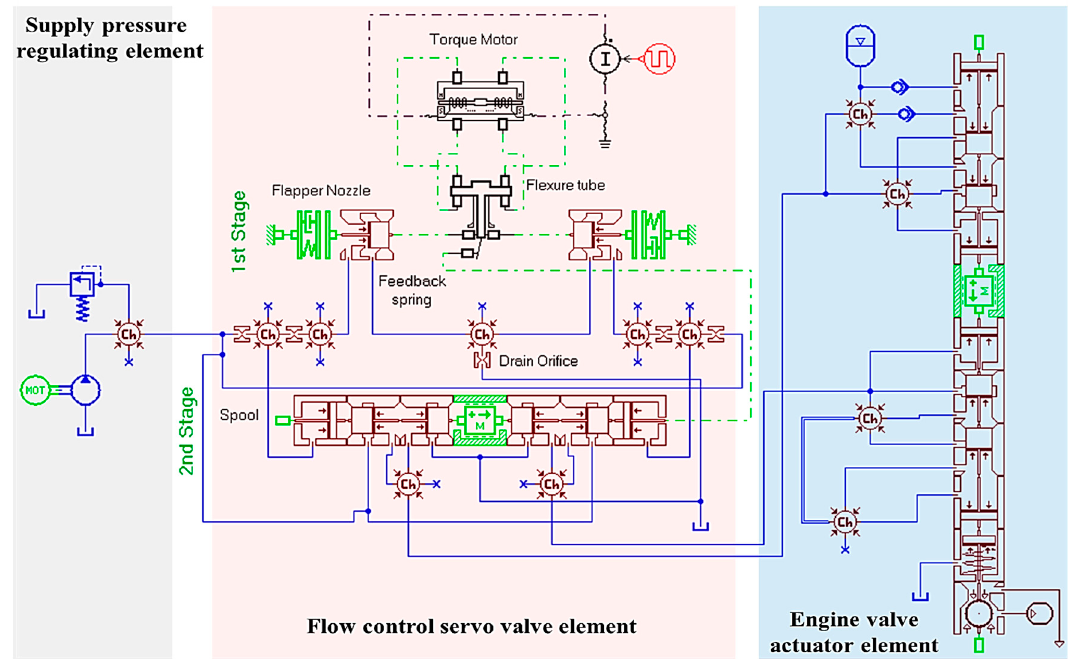
Figure 5. An EH-CEVA AMESim model.